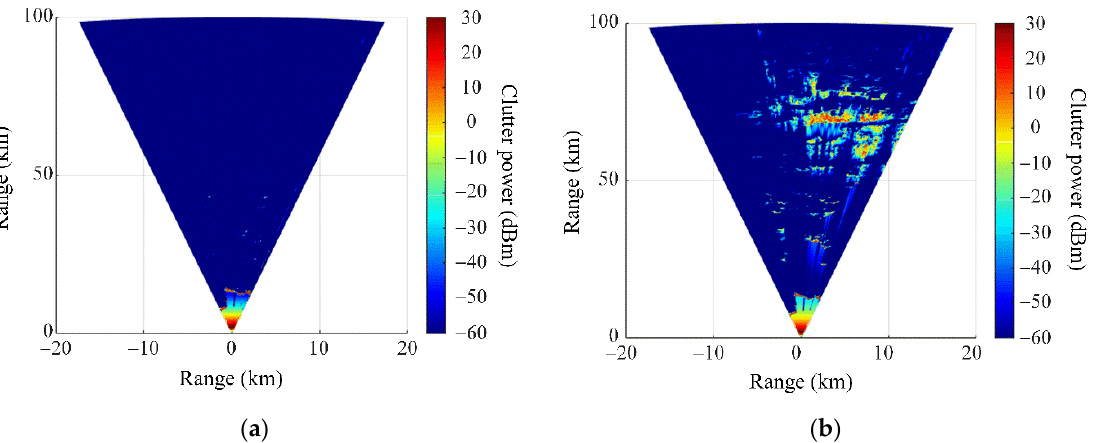
Figure 5. Clutter power spectrums according to atmospheric conditions: ( a ) using the measured data of Case 1; ( b ) using the measured data of Case 2.